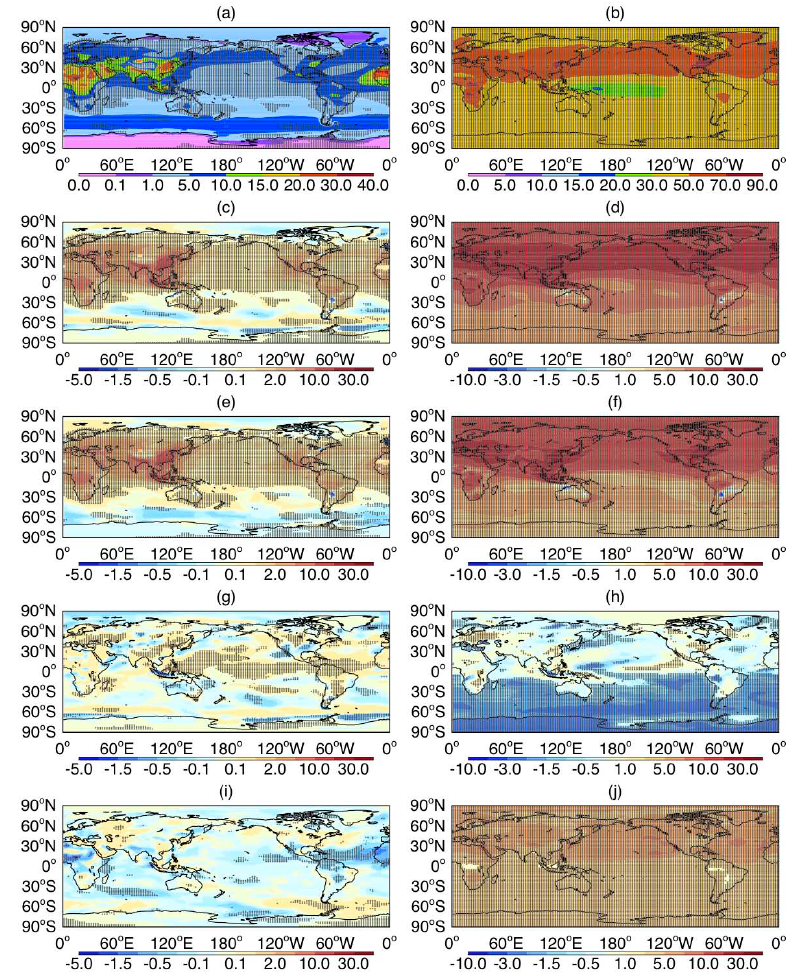
Fig. 3. Annual PM 2 . 5 (left, unit: µgm − 3 ) and H-O 3 (right, unit: ppbv) surface concentration in 2000 (row 1, a and b ), their total changes from preindustrial to present day (“2000” minus “1860” simulations) (row 2, c and d ), and changes over that time interval due to anthropogenic air pollutant emissions only (“2000” minus “2000CL1860EM” simulations) (row 3, e and f ), due to climate change only (“2000” minus “1860CL2000EM” simulations) (row 4, g and h ), and due to the impact of CH 4 increases on tropospheric chemistry only (“1860CL2000EM” minus “1860ALL2000EM” simulations) (row 5, i and j ). Dotted areas indicate changes significant at the 95% confidence level as assessed by student